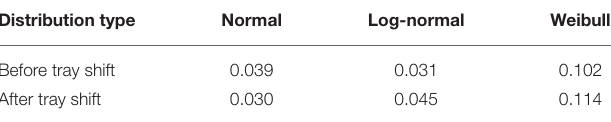
TABLE 4 | Fitting quality data (evaluated by the mean square error) for the 4R type